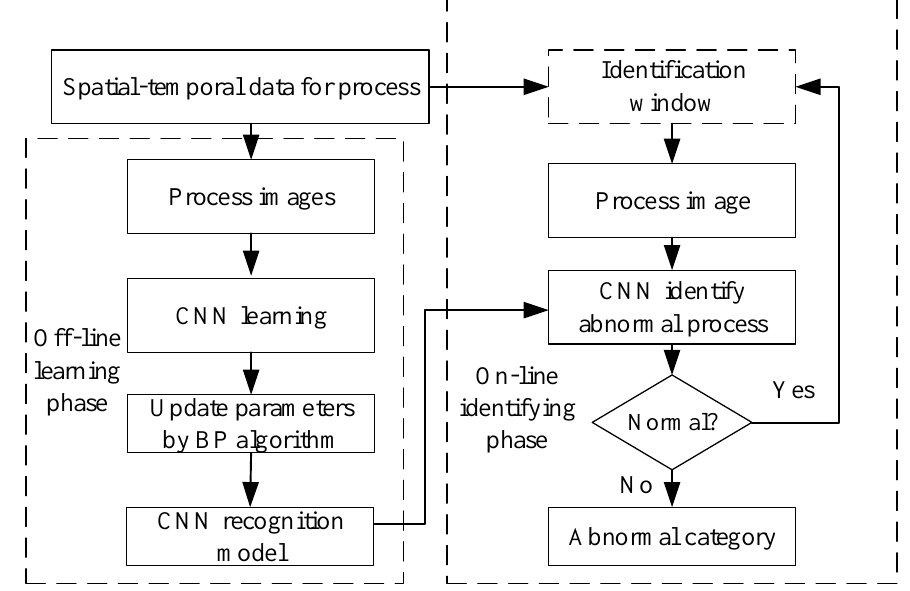
Figure 6. The CNN identification